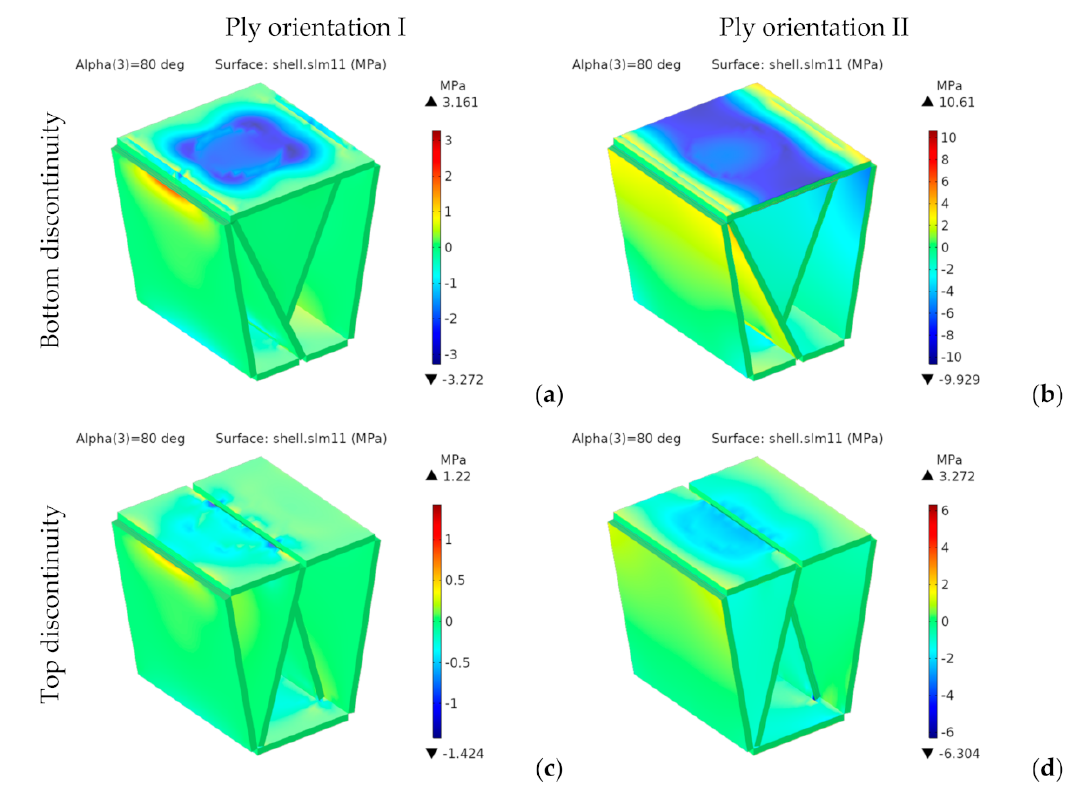
Figure 23. 2nd design. Stress σ xx [MPa] for bottom ( a , b ) and top ( c , d ) discontinuity.